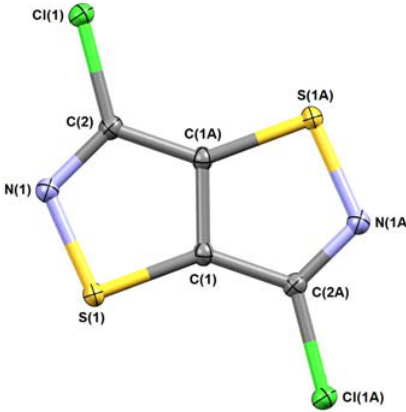
Figure 2. X ‐ Ray structure of 3,6 ‐ dichloroisothiazolo[5,4 ‐ d ]isothiazole ( 8a ). (CCDC 1840070). Thermal ellipsoids are at 50% probability.